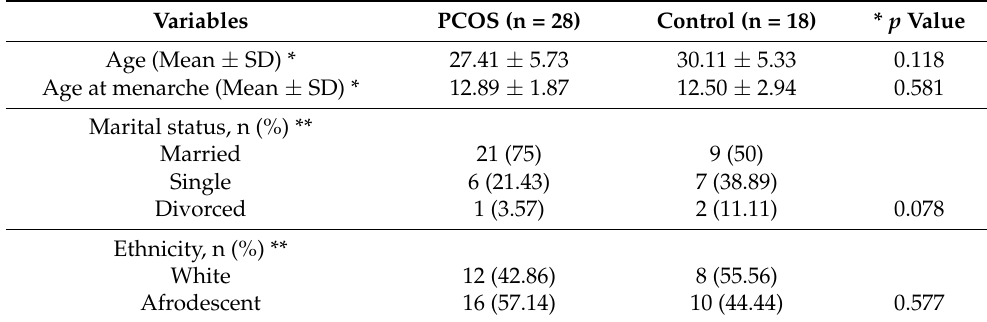
Table 1. Group-wise clinical and sociodemographic